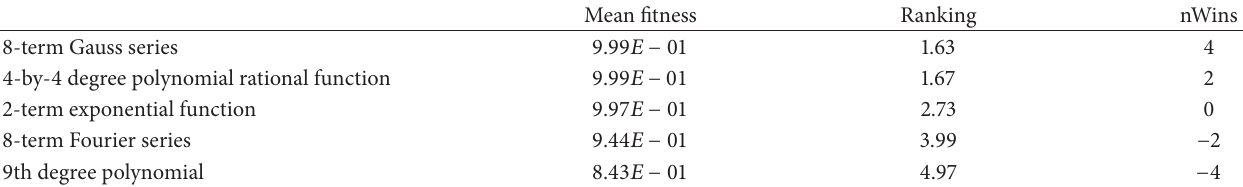
Table 23: Average ranking and number of wins (nWins) in pair-wise comparisons for the best algorithm for each AMPA